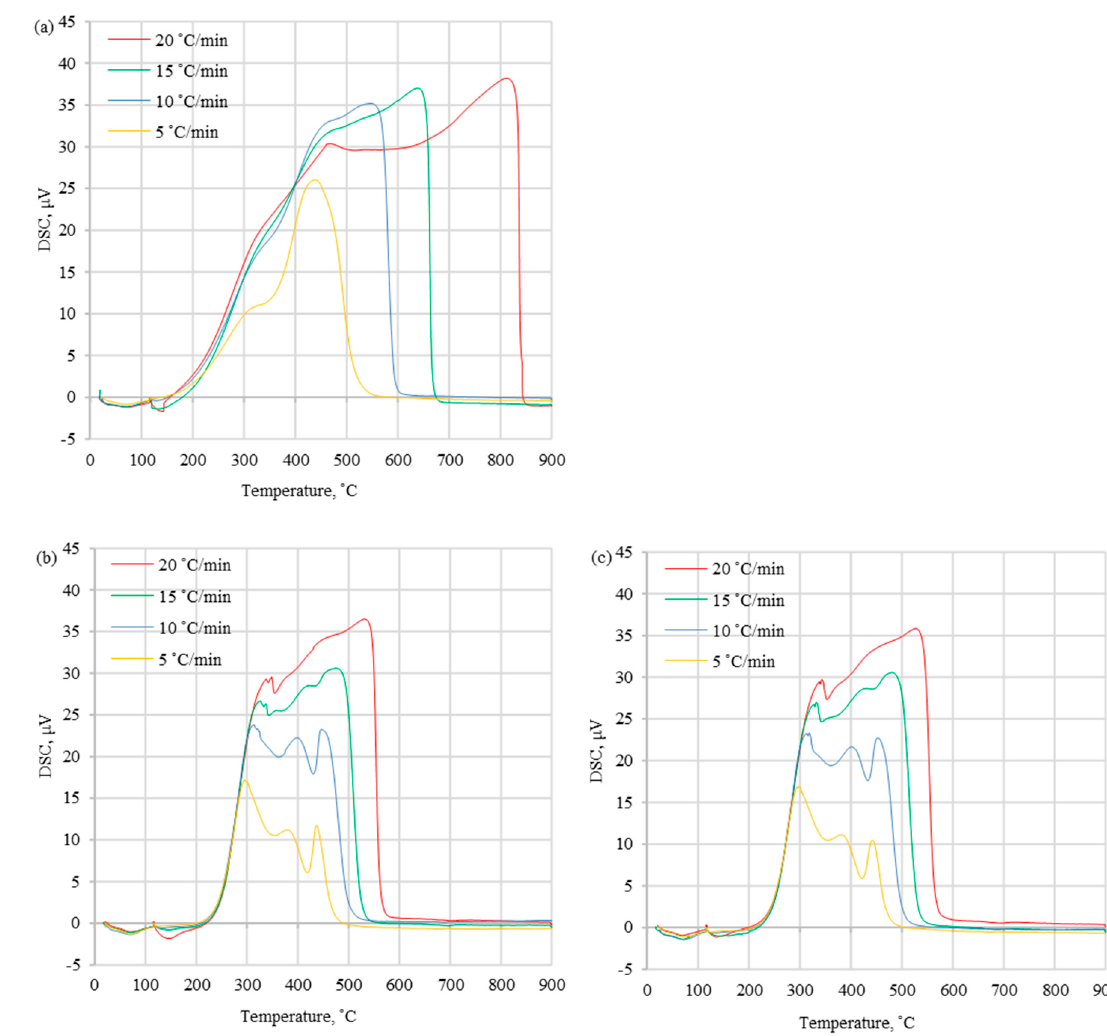
Figure 5. DTG curves for ( a ) WS, ( b ) DS0, and ( c ) DS4 at different heating rates.